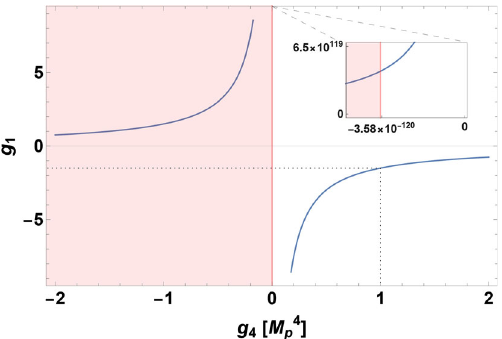
Fig. 3 Dependence of the parameter g 1 on the vacuum energy g 4 for the late times exponential expansion with (cid:2) 0 = 0. The red region indicates the forbidden values for g 4 . The dotted line marks the naive cutoff at Planck scales, for which g 1 = − 3 / 2 g 4 ≈ − 1 . 19 × 10 − 46 GeV 4 .